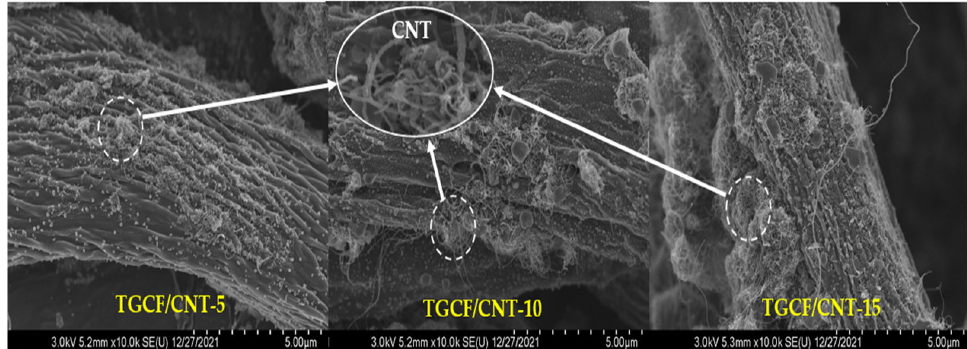
Figure 7. SEM images of TGCF/CNT paper obtained using various cellulose and CNT ratios.